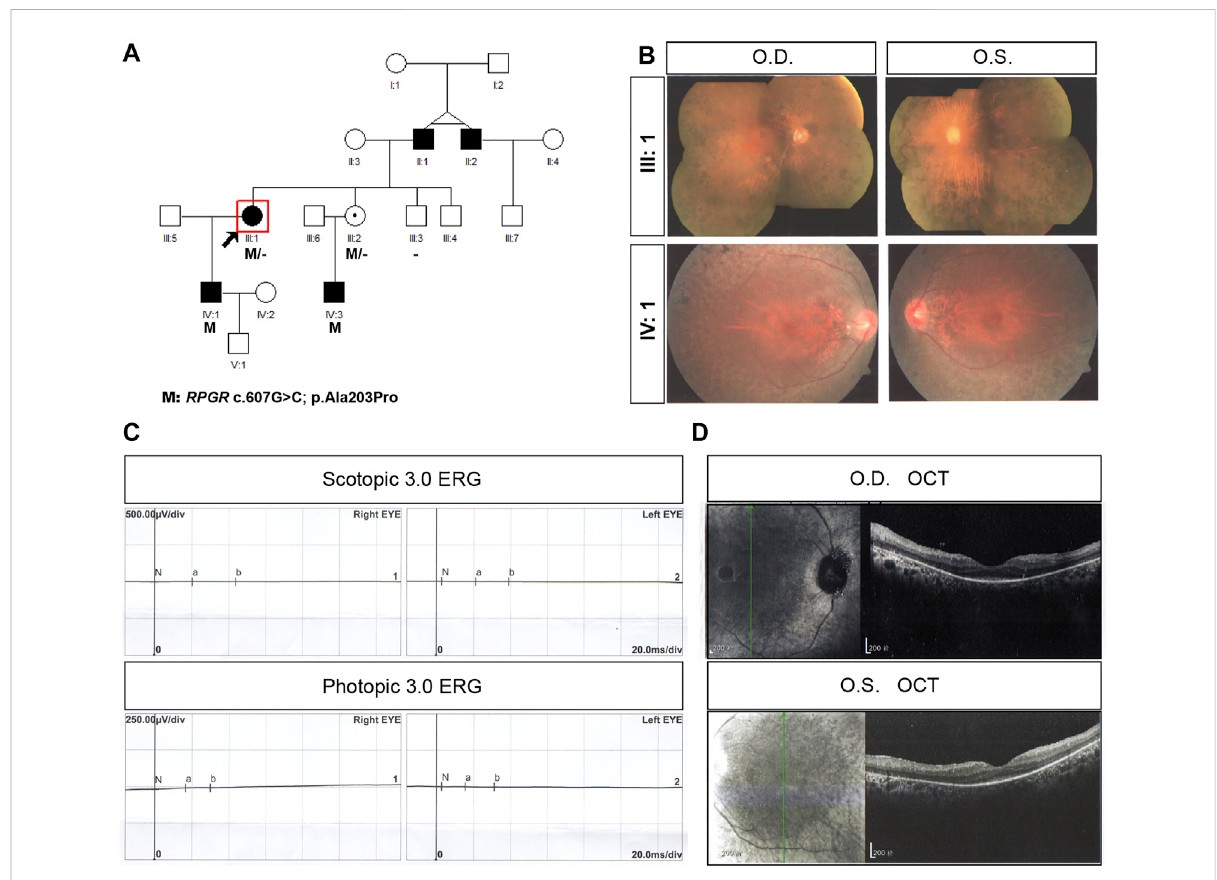
FIGURE 2 Pedigree and images of family P27. (A) Pedigree of family P27; (B) fundus photograph of both eyes of the proband (individual III:1) and IV:1 from the family; (C) scotopic and photopic electroretinogram results of the proband; and (D) F optical coherence tomography image of the both eyes from the proband. Black squares (males) and circles (females) represent individuals affected with RP. Dotted circles (females) represent individuals who are RPGR mutation carriers but who are not affected by RP. Unaffected individuals are not shaded. Black lines indicate deceased individuals. The arrow marks the